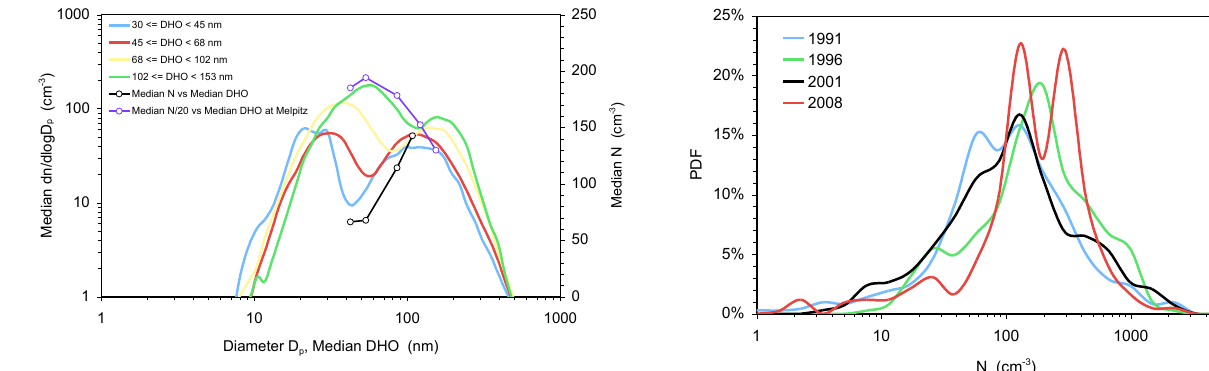
Fig. 9. Probability distribution function PDF of total number con- centrations (N, cm 3 ) in 1991, 1996, 2001, and